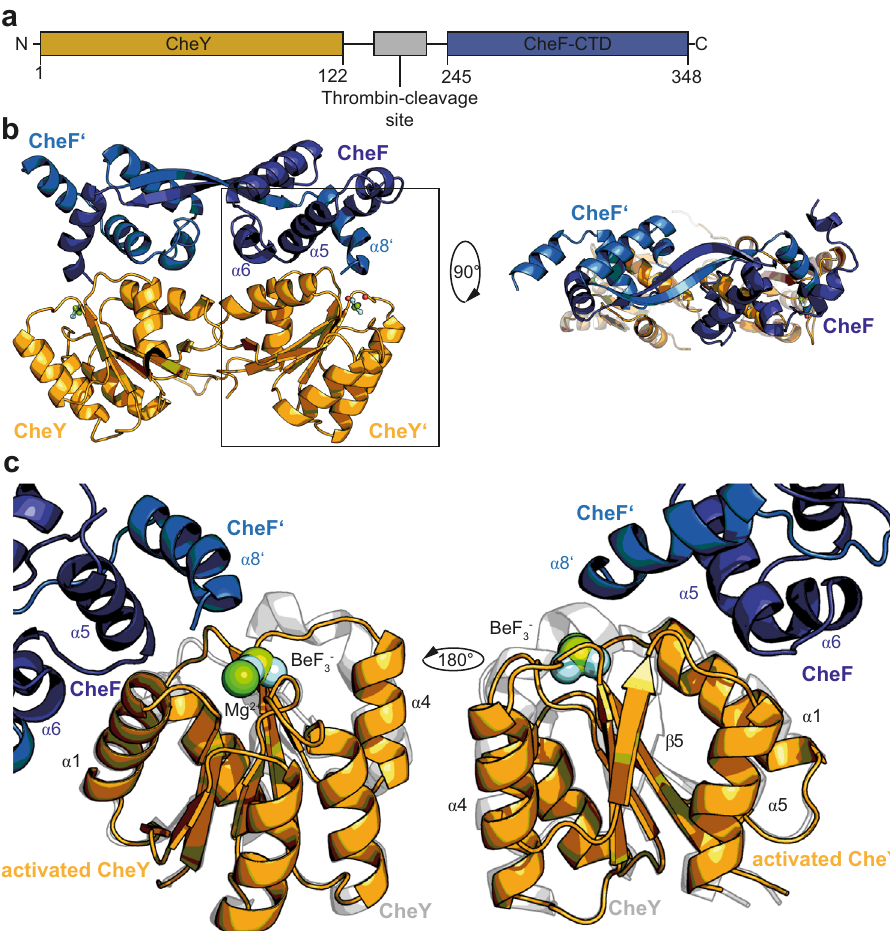
Fig. 4 CheY-P interaction involves a complex interface at CheF formed by both molecules of the dimer. a Domain architecture of the MmCheY:CheF CTD fusion construct. b Crystal structure of the MmCheY:CheF CTD fusion construct. c Closeup of the binding site of CheY at CheF. The interaction interface involves α 5, α 6 from one CheF molecule and α 8 from the other molecule of CheF. MmCheY is colored in orange and the CTD of MmCheF is colored in blue. The non-phosphorylated CheY (PDB: 6EKG) has been superposed and is shown in gray in the background to depict the structural differences between activated- and apo-CheY.